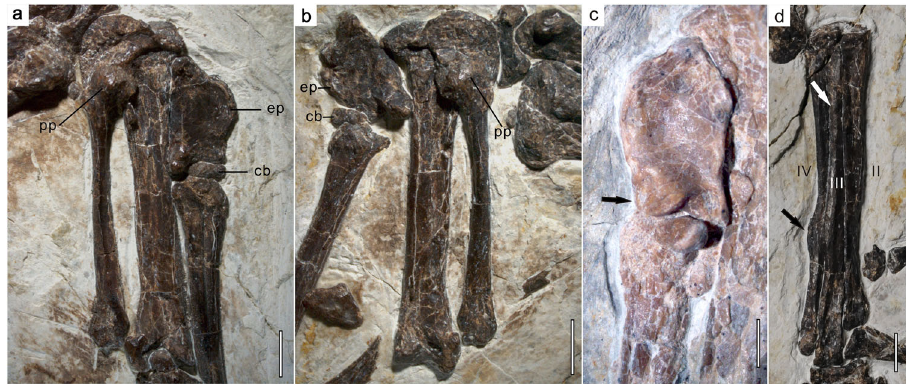
Fig. 7 Selected limb elements of Confuciusornis shifan holotype (PMoL-AB00178). a left carpometacarpus. b right carpometacarpus. c left alular metacarpal of the confuciusornithid specimen PMoL-AB00150. d right tarsometatarsus. Carpometacarpi are in palmar view, and tarsometatarsus is in cranial view. cb cushion-like bone, ep extensor process, pp pisiform process. Roman numerals in ( d ) identify metatarsals. Black arrow in ( c ) indicates the cranial distal condyle of the alular metacarpal; black and white arrows in ( d ) indicate the ridge-like process on metatarsal IV and the dorsal tubercle on metatarsal III, respectively. Scale bars: